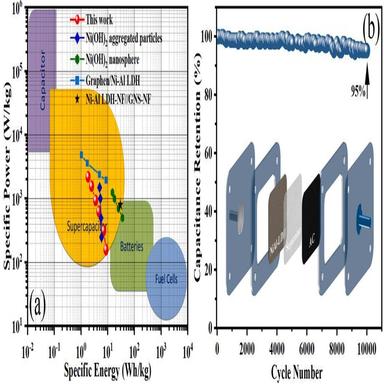
a) Ragone plot of the NiAl-LDH //AC asymmetric hybrid supercapacitor cell compared to corresponding previous reported studies ; b) The cycling stability test at 10,000 cycles and a schematic of the two-electrode cell (inset).